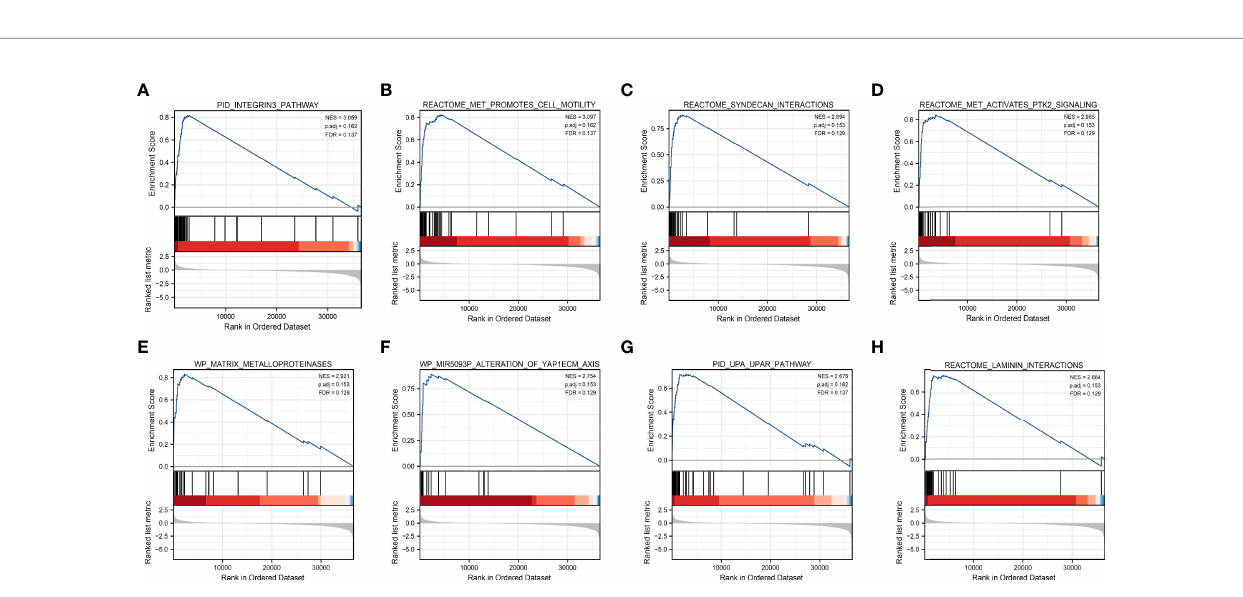
FIGURE 5 | Gene set enrichment analysis of DCBLD1 in HNSCC. (A) Integrins 3 pathway. (B) Met promotes cell motility. (C) Syndecan interactions. (D) Met activates PTK2 signaling. (E) Matrix metalloproteinases. (F) MIR5093P alteration of the YAP1ECM axis. (G) UPA UPAR pathway. (H) Laminin interactions. NES, normalized enrichment score; FDR, false discovery